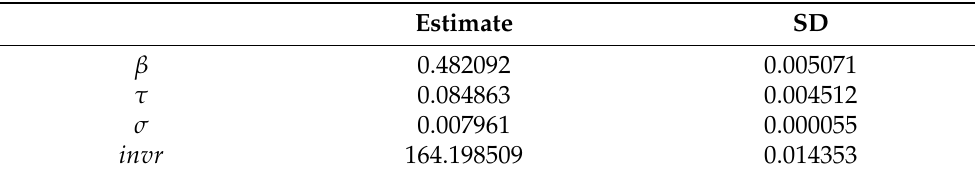
Figure 5. Time series plot of the median distance between clusters of the top five countries from each continent. Table 1. Estimate of the parameters in the latent space model. The first column contains the posterior mean. The second column contains the posterior standard deviation. β is the regression coefficient, τ is the standard deviation of latent coordinates on the first day, σ is the standard deviation of daily transition in coordinates, and invr is the mean of inverse of country-specific